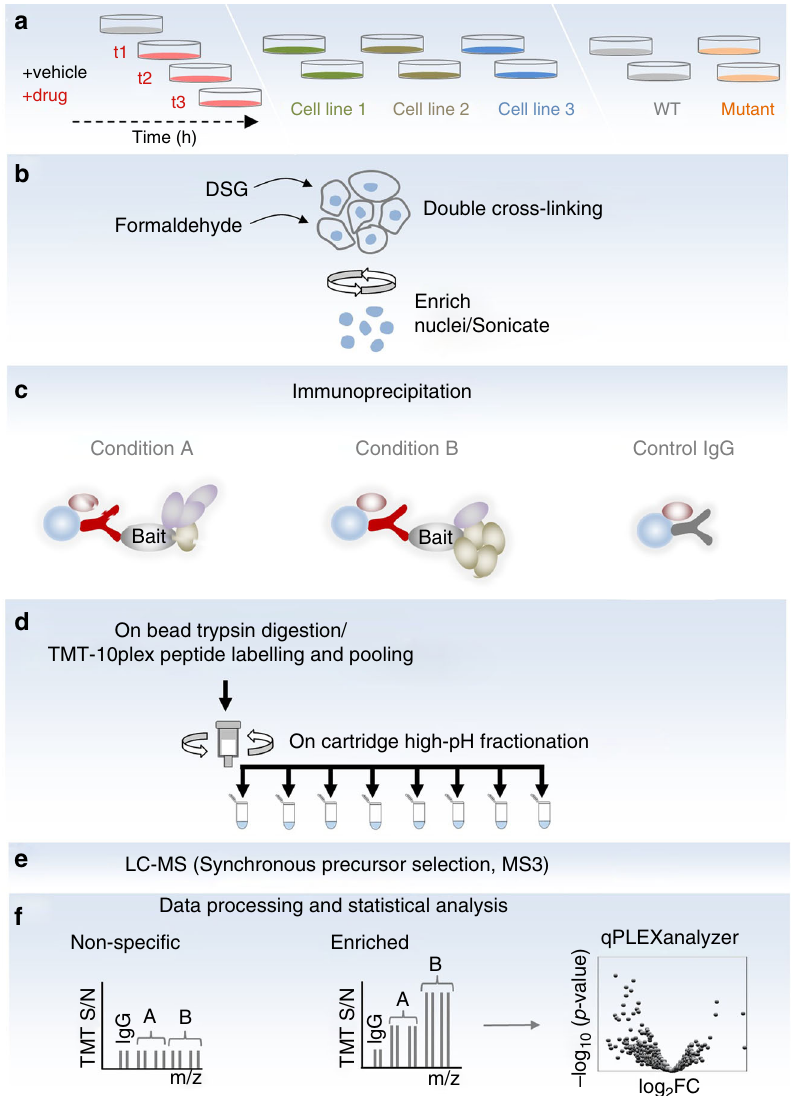
Fig. 1 The qPLEX-RIME work fl ow. Proteins in treated and un-treated cell cultures at different time points or in variable genomic backgrounds (e.g. different cell lines or mutated conditions) are double-crosslinked and cell nuclei are isolated and sonicated ( a , b ). Target protein complexes are immunoprecipitated and subjected to on-bead trypsin digestion ( c , d ). The generated peptides are labelled using different TMT reagents and pooled in a single mixture, which is fractionated using Reversed-Phase cartridges ( d ). Peptide fractions are analysed with the MultiNotch MS3 method ( e ) followed by data processing